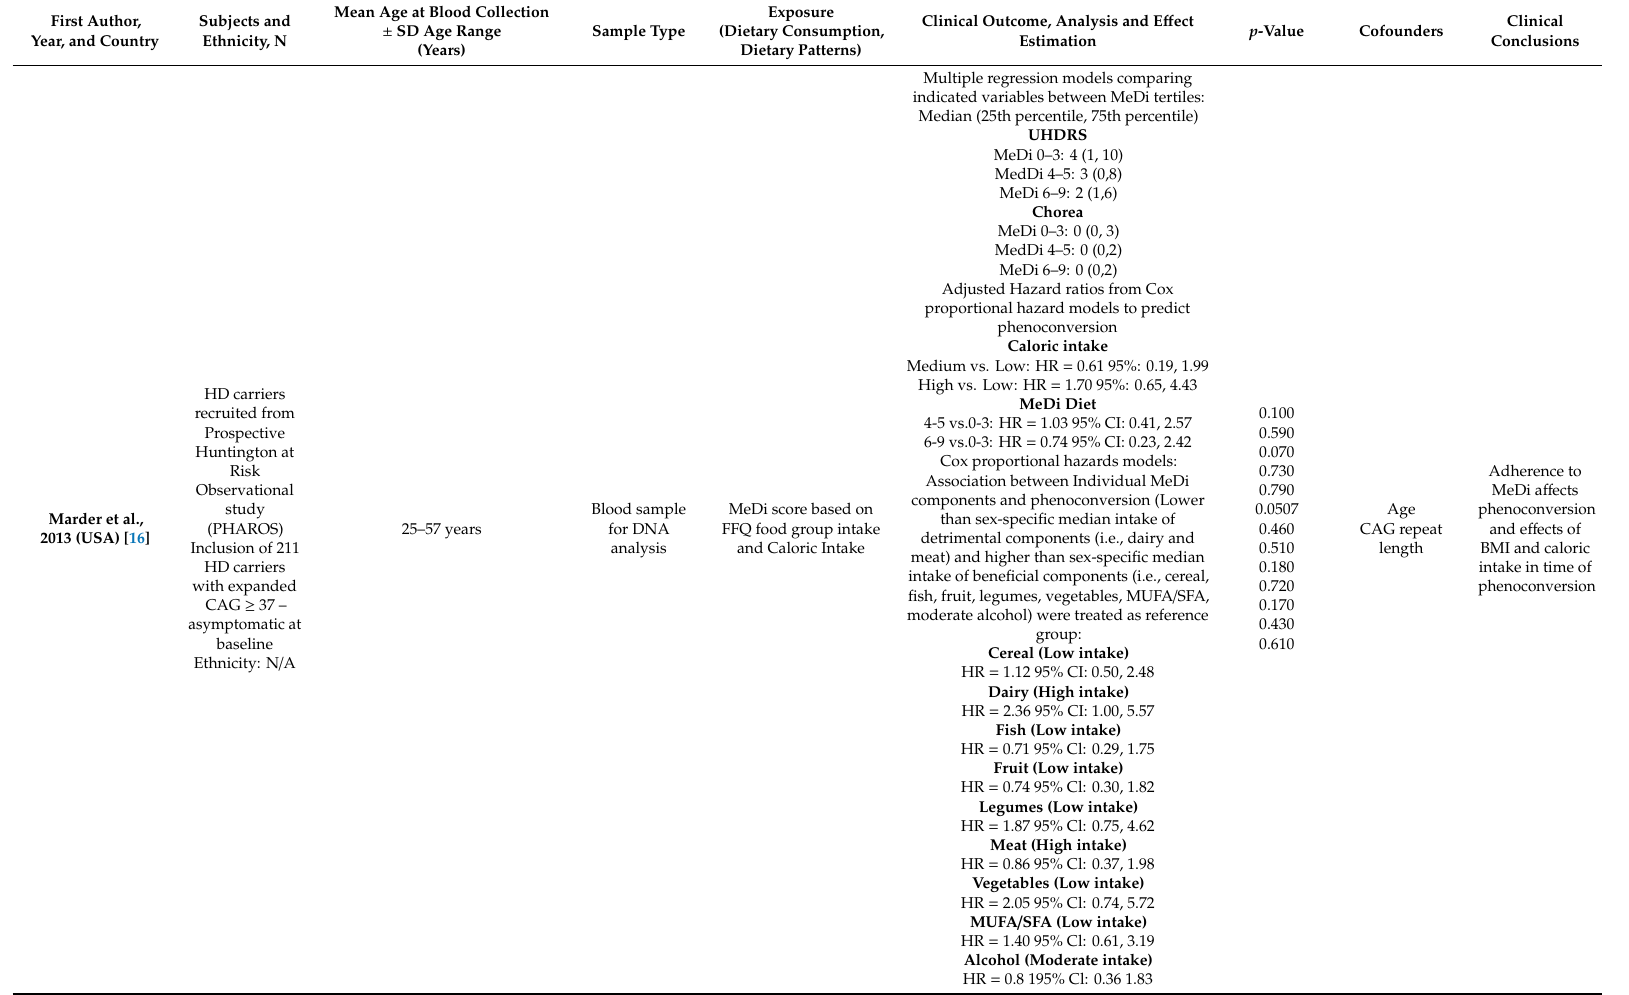
Table 2. Characteristics of studies investigating the association of Mediterranean Diet, caloric intake and dietary pattern on Huntington’s